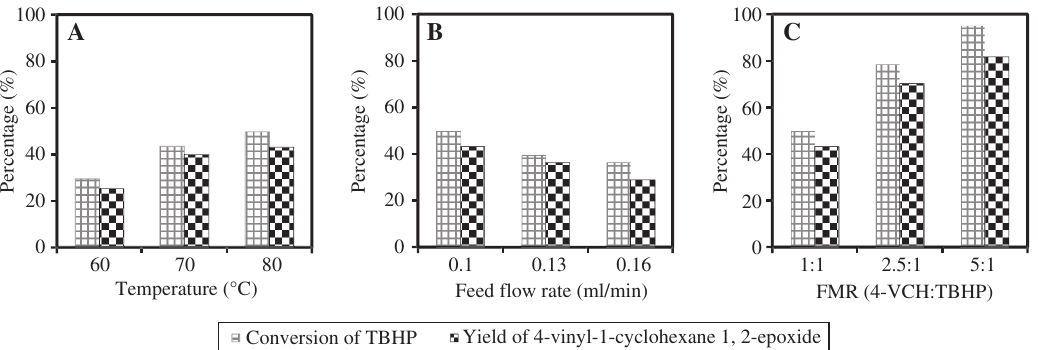
Figure 5 Conversion of tert -butyl hydroperoxide (TBHP) and the yield of 4-vinyl-1-cyclohexane 1,2-epoxide (4-VCH 1,2-epoxide) at steady state for continuous epoxidation of 4-VCH with TBHP using a FlowSyn continuous flow reactor in the presence of polystyrene 2-(aminome- thyl)pyridine supported Mo(VI) complex (Ps.AMP.Mo) catalyst ( ∼ 1.5 g): (A) effect of reaction temperature at feed flow rate: 0.1 ml/min; feed molar ratio (FMR) of 4-VCH to TBHP: 1:1; (B) effect of feed flow rate at reaction temperature: 80 ° C; FMR of 4-VCH to TBHP: 1:1. (C) effect of FMR of 4-VCH to TBHP at reaction temperature: 80 ° C; feed flow rate: 0.1